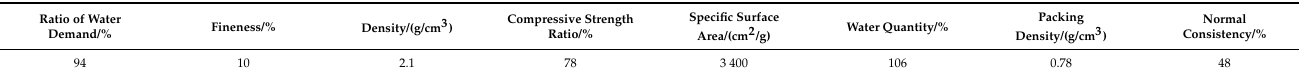
Table 2. Basic physical properties of fly ash.